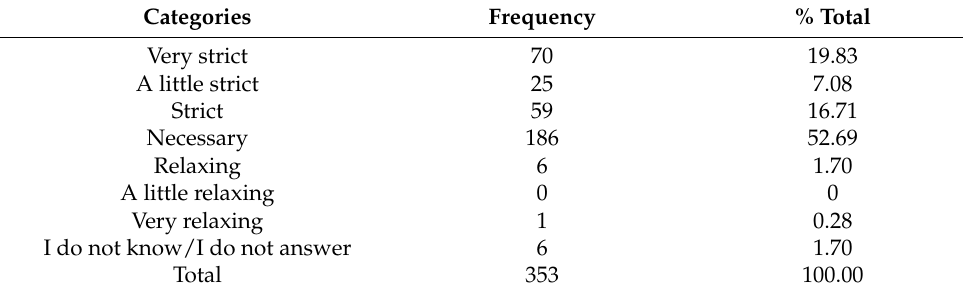
Table 2. Results for the measures of the State for